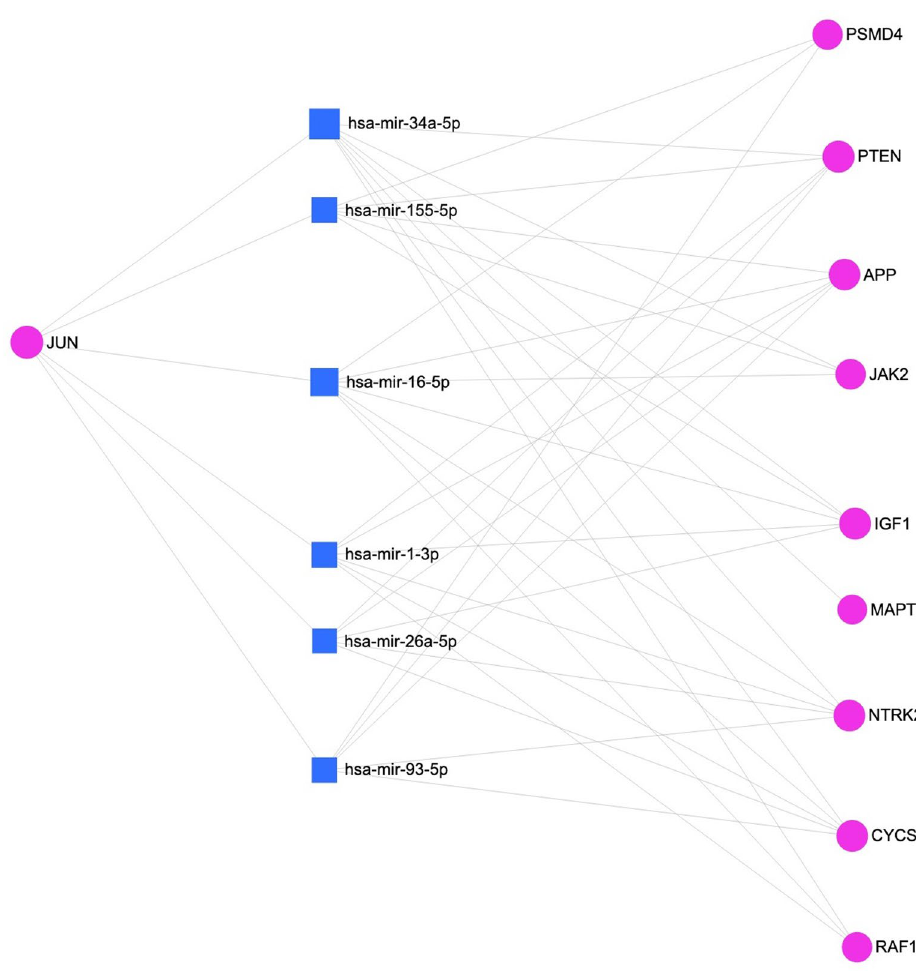
Figure 6. Network generated by miRNet. It shows six important miRNAs, represented by blue squares, and highlights JUN as the critical transcription